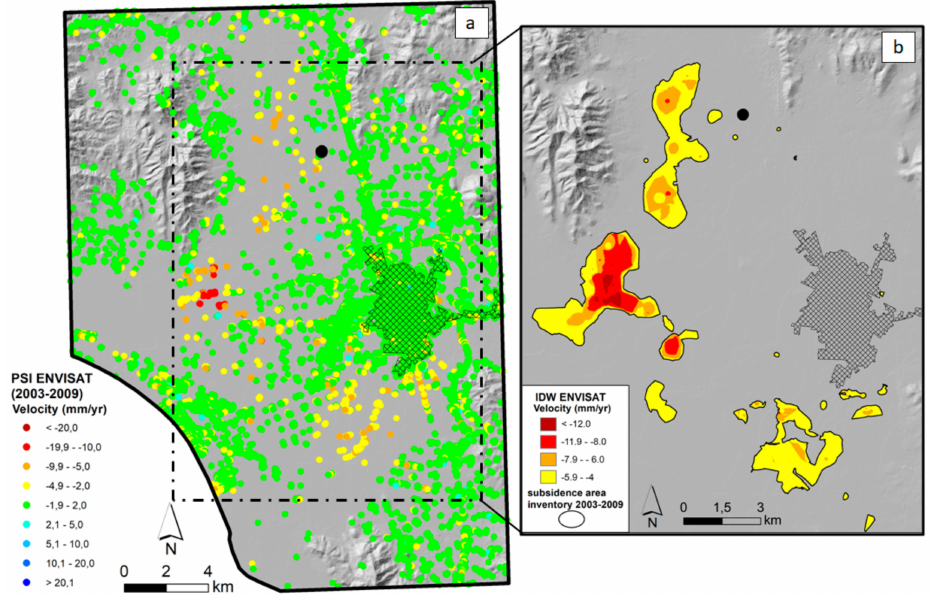
Figure 3. ( a ) Spatial distribution of mean annual velocities of merged ascending and